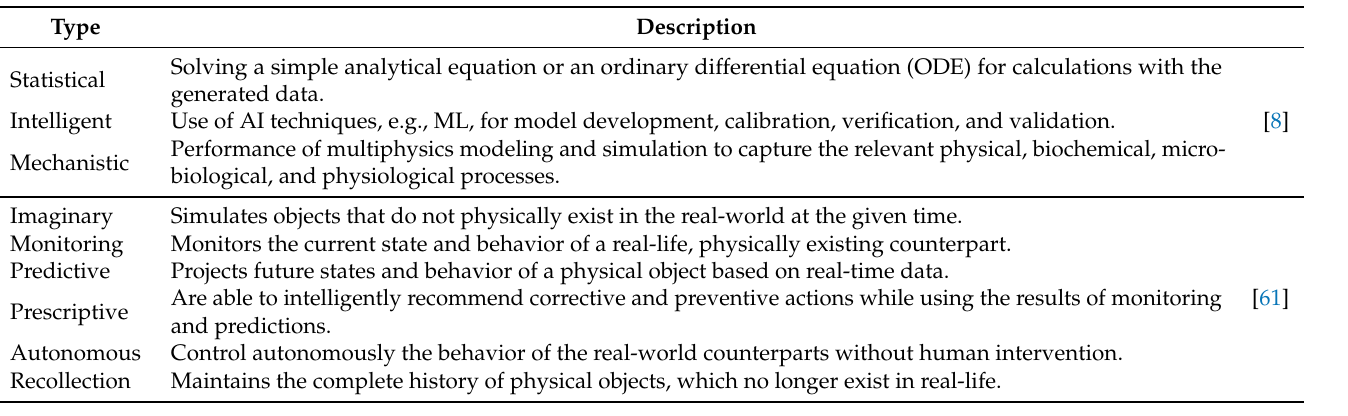
Table 1. Digital twin taxonomy (based on [8,61]).